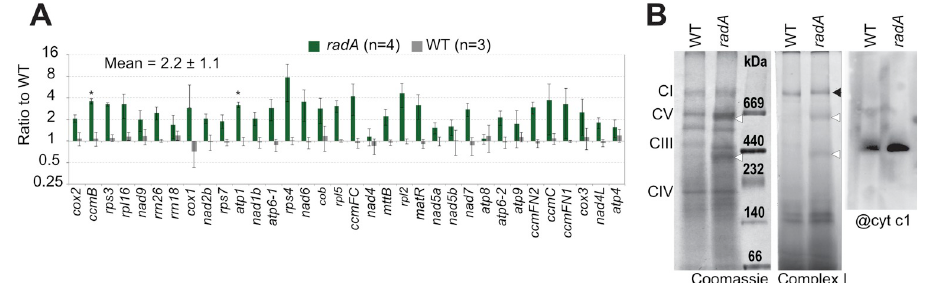
Fig 8. Accumulation of mitochondrial transcripts in radA . (A) Representative mitochondrial transcripts were quantified by RT-qPCR, from the RNA of 10-day-old seedlings grown in vitro , and normalized against a set of nuclear housekeeping genes. Results are on a log2 scale and are the mean from four biological replicates (two pools of radA-1 and two pools of radA-2 seedlings) with the corresponding SD error bars. The asterisks indicate significance of p < 0.01 by Student’s t test. (B) Blue-Native gel analysis of purified mitochondria from WT and radA-1 plants. 80 μ g of proteins were loaded in each well, and run in parallel with size markers (High Molecular Weight Calibration Kit, GE Healthcare). The identifiable OXPHOS complexes (CI, CII, CIV and CV) are indicated. Coomassie staining, complex I activity staining and immunodetection of complex III, with a cytochrome c1-specific antibody, revealed no apparent deficiency in the assembly of OXPHOS complexes in radA . The white arrowheads indicate green-yellow bands that were already visible before staining and likely corresponded to contaminating plastidial complexes. The black arrowhead indicates the complex I activity